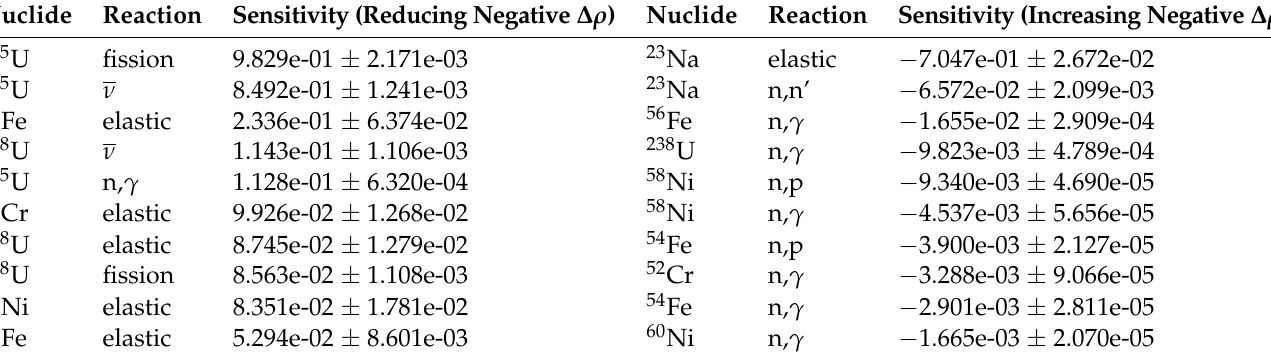
Table 7. EBR-II: top sodium void worth sensitivities (all sodium removed, ∆ ρ = − 4681 ± 29 pcm; top 10 positive and top 10 negative mixture-, region- and energy-integrated sensitivities, determined with TSUNAMI-CE using ENDF/B-VII.1 data).